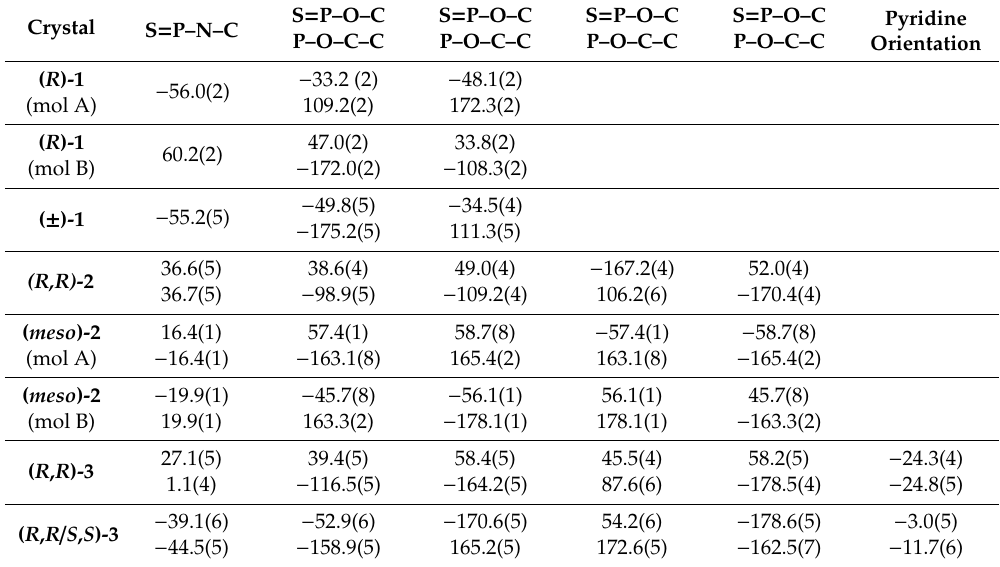
Table 2. Selected torsion angles (deg.) in the ligands and